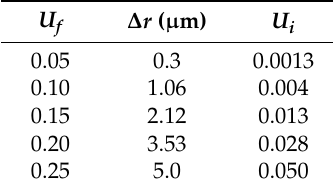
Table 2. Interphase thickness and volume fraction for various filler